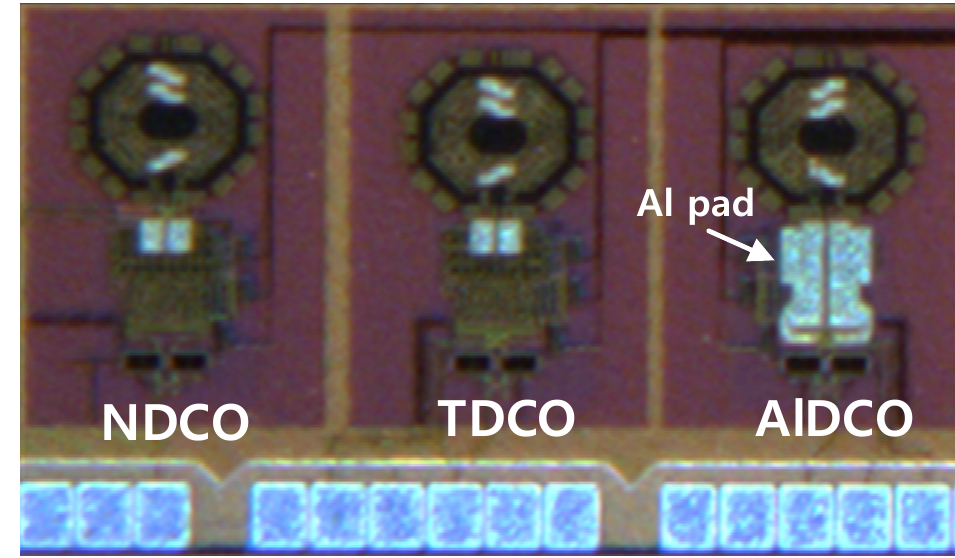
Figure 7. The die photo of the designed DCOs.